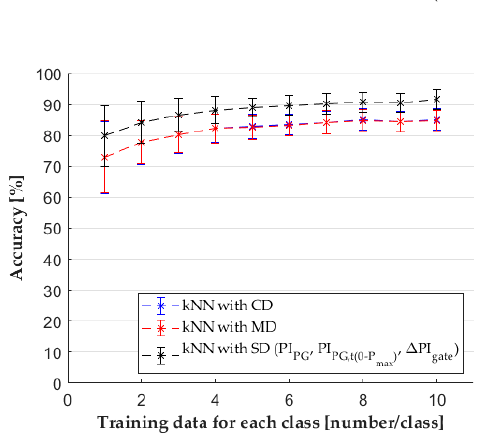
Figure 8. The results of classification with different feature sets.